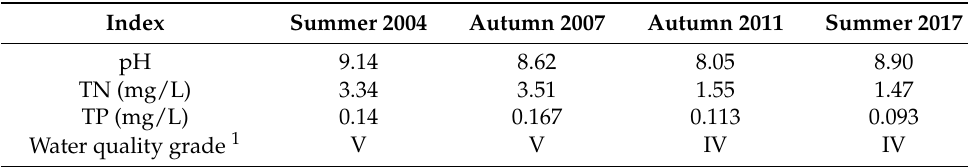
Table 1. The main characteristics of water quality in Huanggai